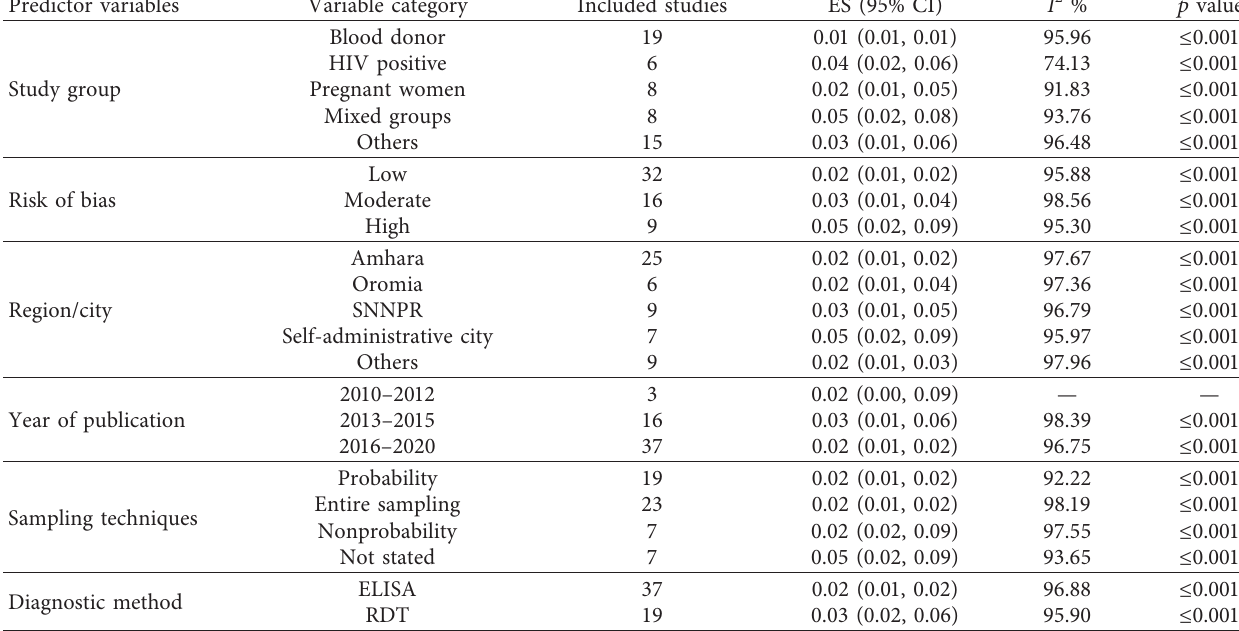
Table 2: Subgroup analysis of the anti-HCV pooled prevalence estimation in Ethiopia, 2020.